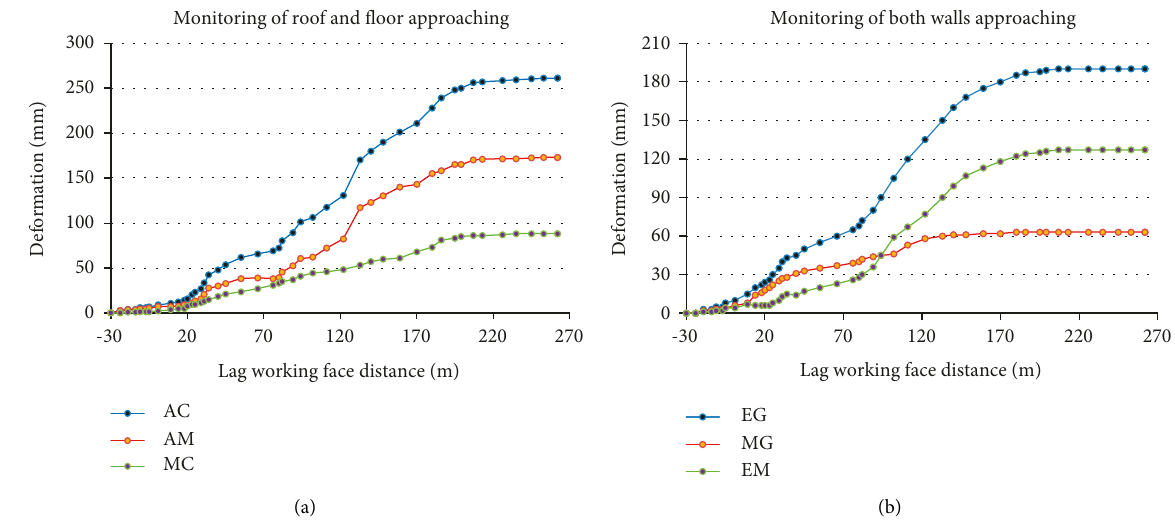
Figure 18: Typical monitoring results at footage 500m. (a) Monitoring of roof and floor approaching. (b) Monitoring of both walls